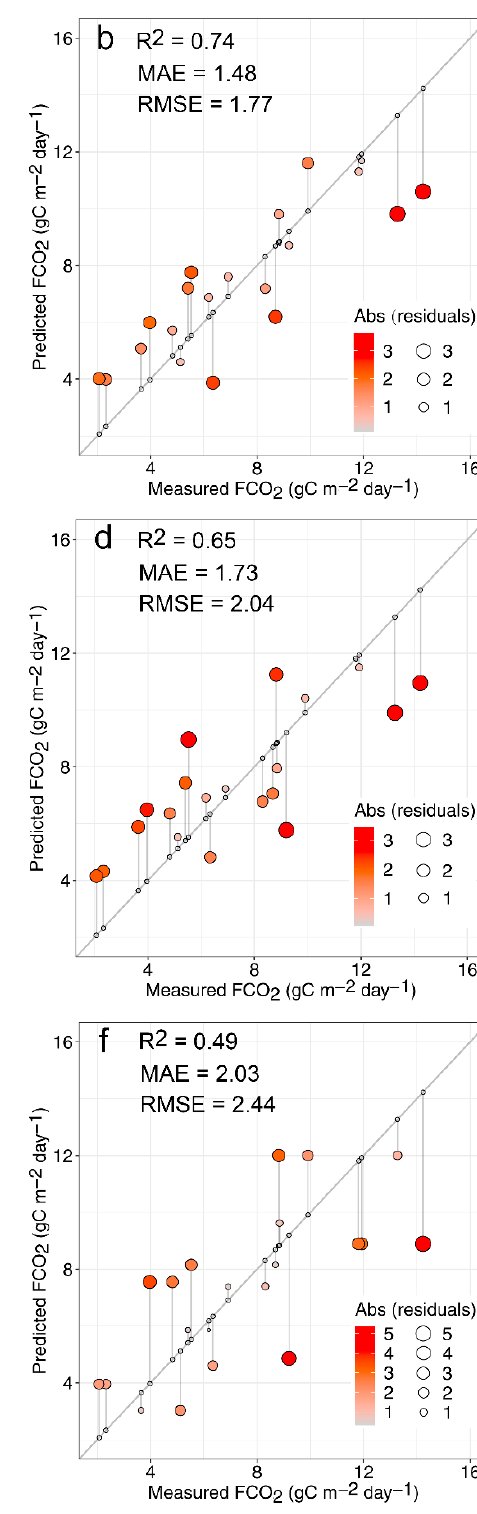
Figure 7. Scatter plots showing the relationship between measured and predicated FCO 2 for the training datasets ( n = 49) in the left column and the testing datasets ( n = 21) in the right column. ( a , b ) The results are computed using the optimal RF model with the 4 selected features. ( c , d ) The results are derived from the RF model developed using the 10 original variables. ( e , f ) The results are calculated based on the MLR model that also constructed using the best 4 selected variables and field-measured FCO 2 as the model input data. The color bar and circle represent the absolute residuals between the measured and predicated FCO 2 .